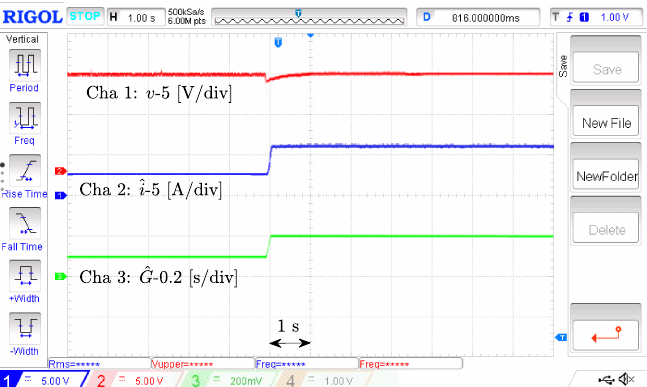
Figure 11. The response curves of boost converter under the proposed controller in the presence of a step change in G